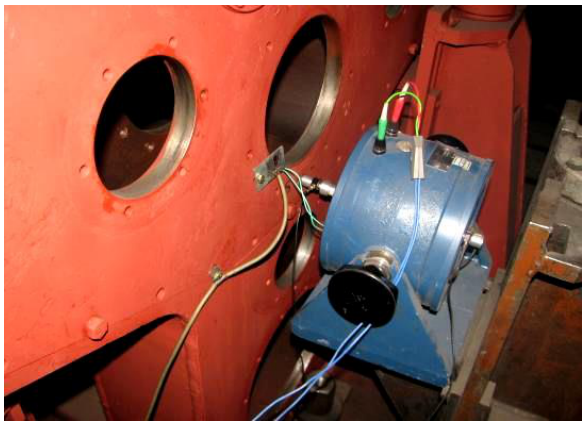
Figure 16. Detail of the vibration measurement and analysis installation.